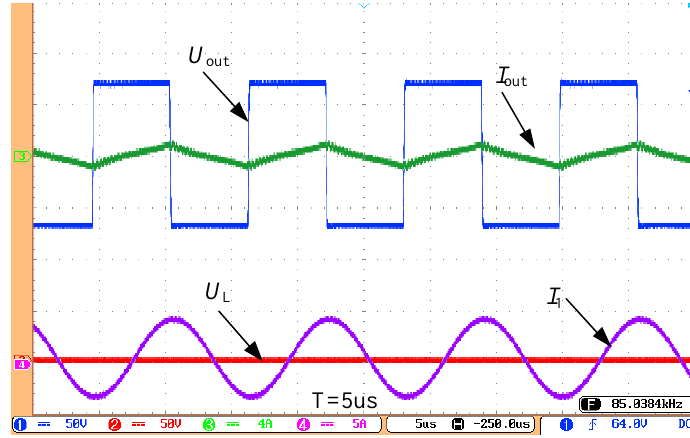
Figure 13. Experimental waveforms without the secondary side.